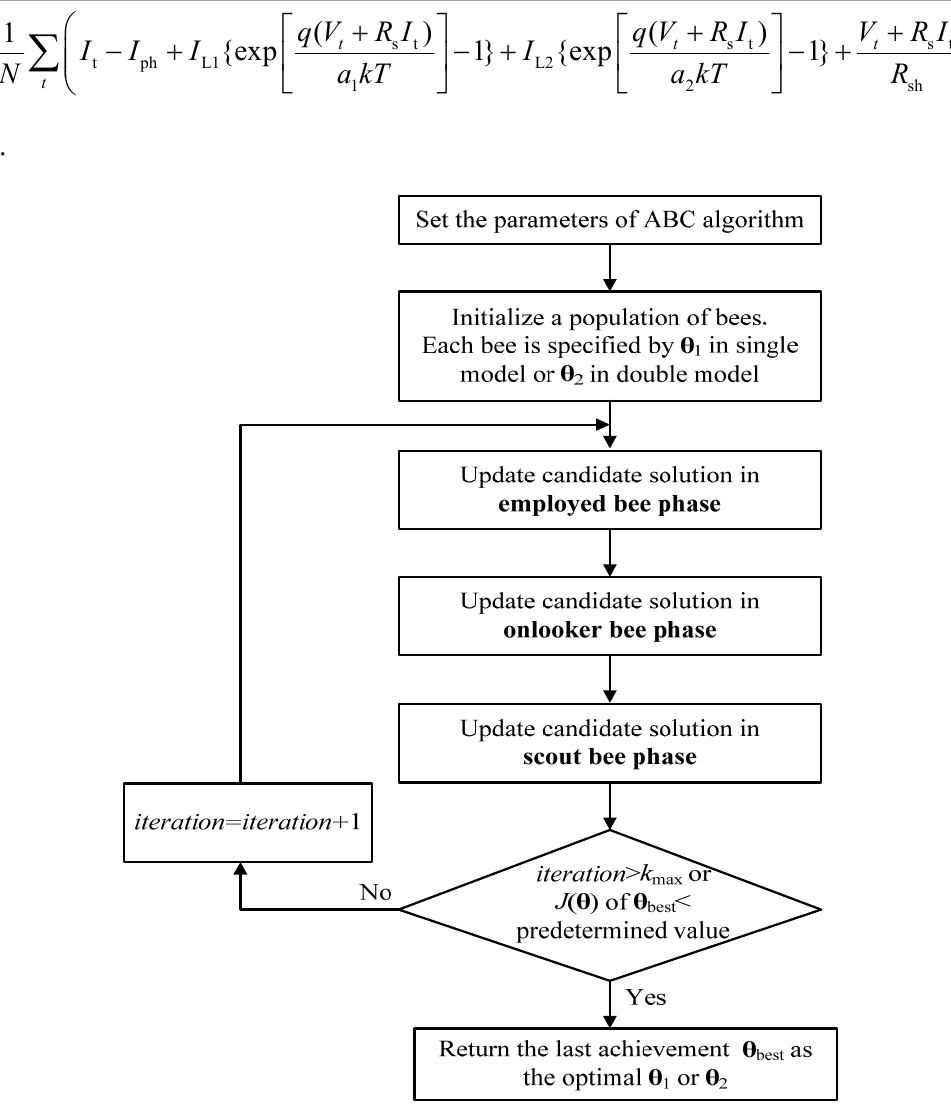
Figure 4. Flowchart of the proposed